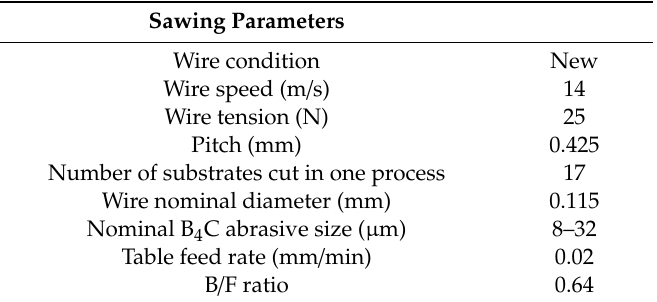
Table 1. Common process parameters.